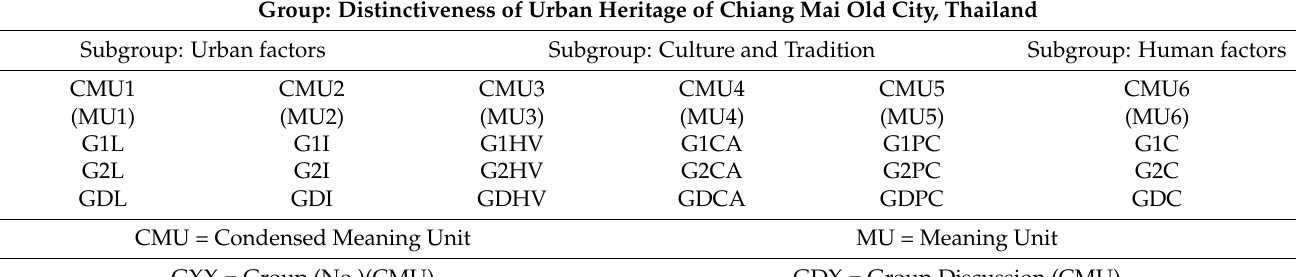
Table 4. The example of focus group analysis in this study (Author).